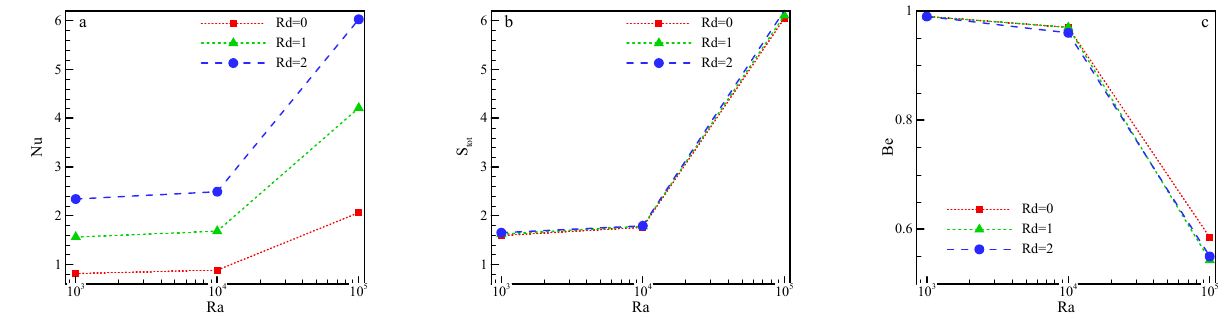
Figure 6. Mid Nu ( a ), total EGE ( b ), and Be ( c ) for Ha = 20, AR = 0.45 − 0.6, γ = 45, ω = 0, ϕ = 0.03, and different Rayleigh number and RAP values.